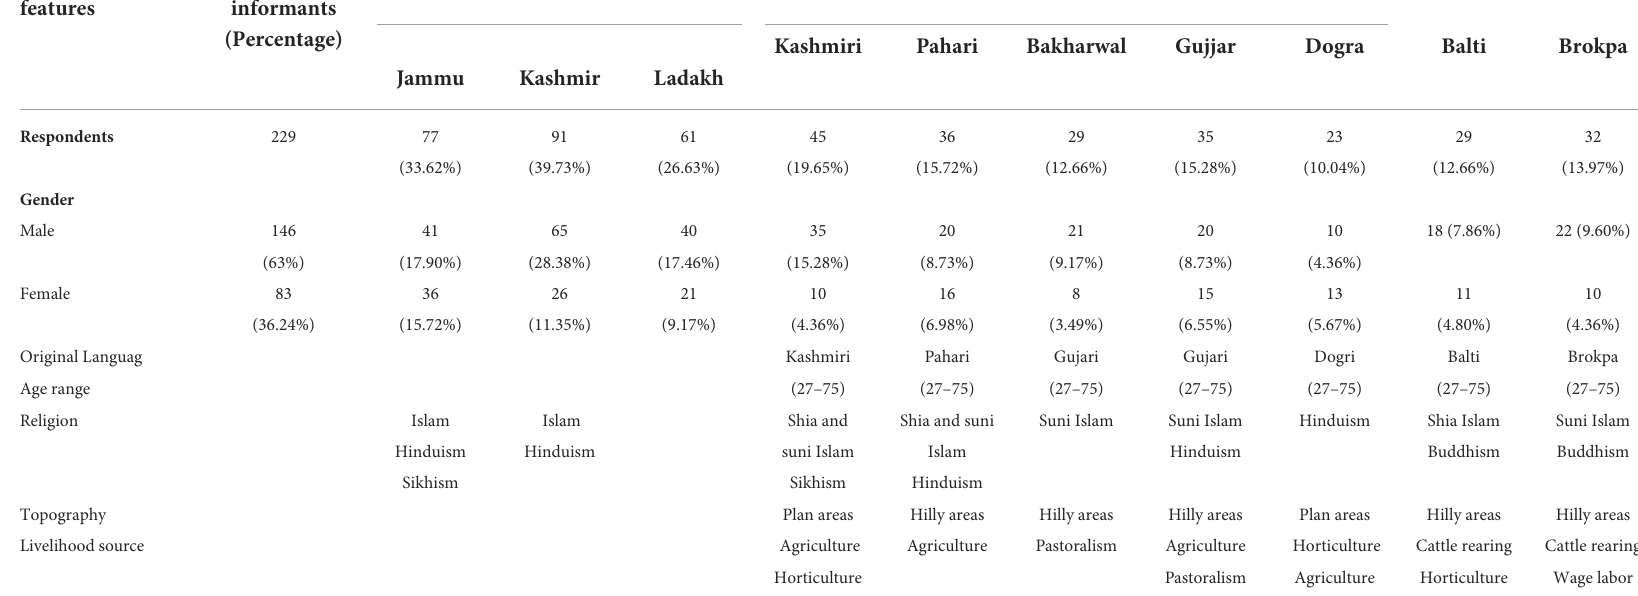
TABLE 1 Demographic status of the respondents from the study